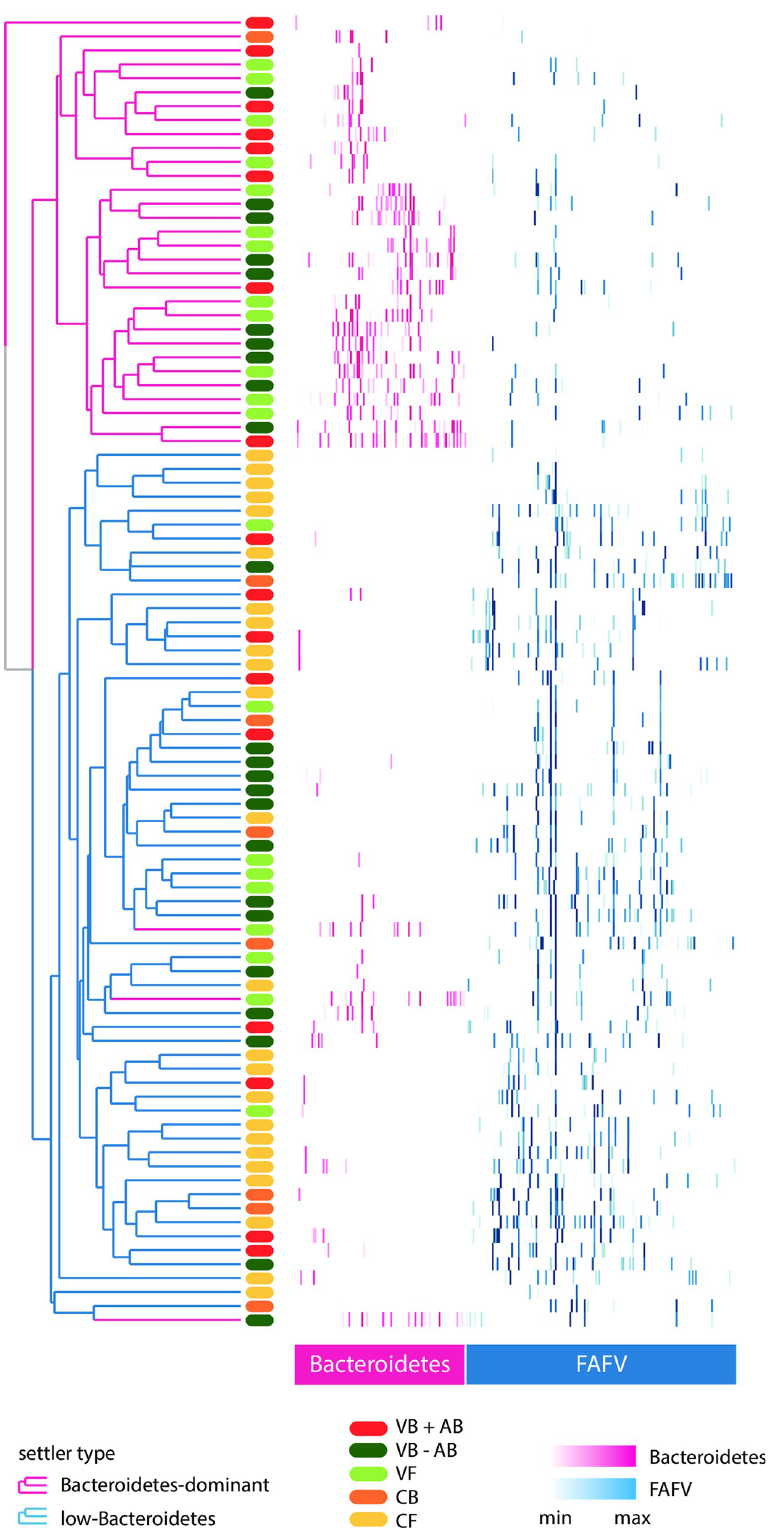
Fig 1. Heat map of all profiles at T = 1 (one week), sorted and colored by phylum. Abundance of OTUs in each sample at T = 1 (one week). Rows correspond to samples (antibiotic treatment: red; vaginal delivery: green; caesarean